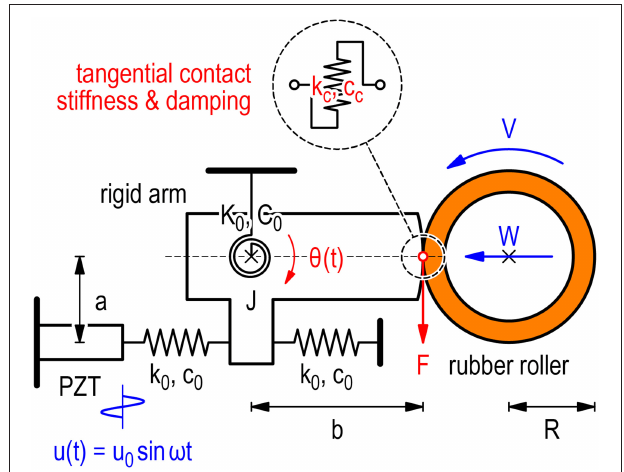
FIGURE 1 | Investigated system: scheme of the measuring system for dynamic response of rubber in sliding